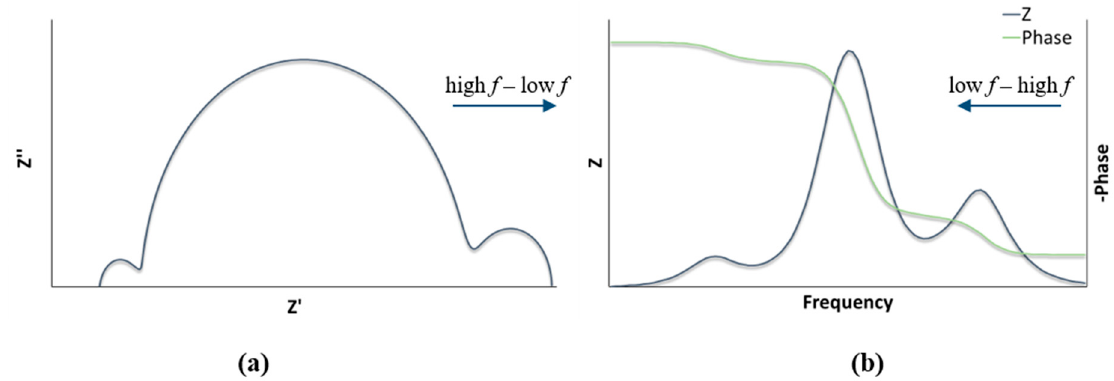
Figure 2. ( a ) Nyquist plot representation; ( b ) Bode plot representation.